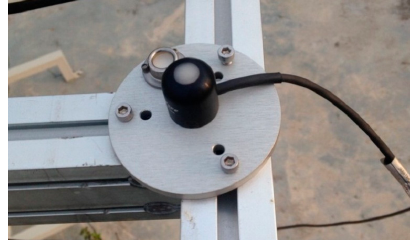
Figure 10. Apogee Instruments pyranometer solar radiation sensors.